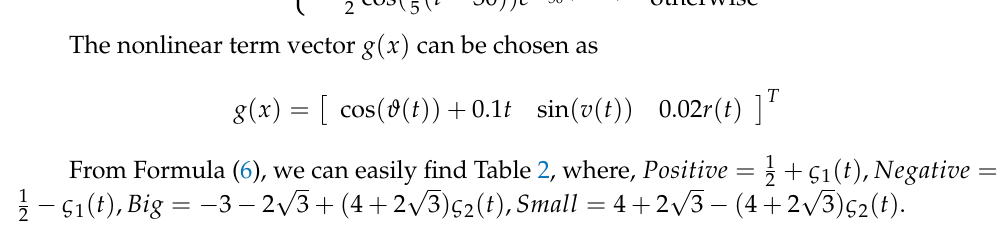
Table 2. Rule table of the T-S fuzzy model. Rule Number ς 1 ( t ) ς 2 ( t ) 1 Positive Big 2 Positive Small 3 Negative Big 4 Negative Small Additionally, in the simulation, after 30s we assume a loss of effectiveness 40% and stuck at 0.1 sin ( 2 t ) on the bow tunnel thruster and the aft tunnel thruster I,